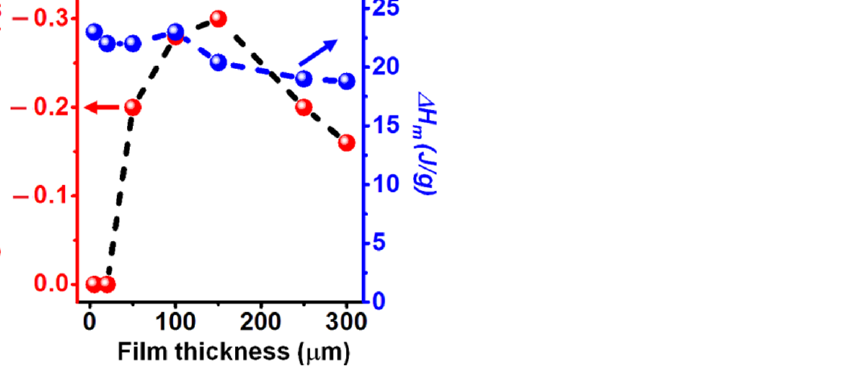
Figure 2. Degree of orientation ( f c , left scale) and melting enthalpy (right scale) of NC PPO films versus thickness of the starting amorphous films. For f c = − 0.5, all polymer chain axes of crystallites are perfectly perpendicular to the film plane.